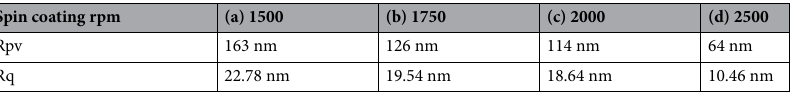
Table 2. Summarize of the AFM results of ZnO according to PMMA spin coating speed 1500–2500 rpm.